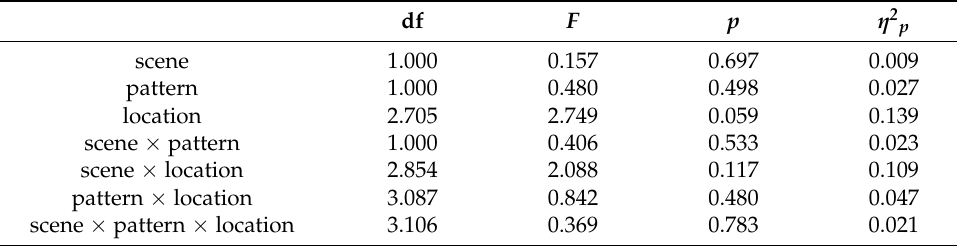
Table 5. The main effect of three-way repeated measures ANOVA in y -axis gaze